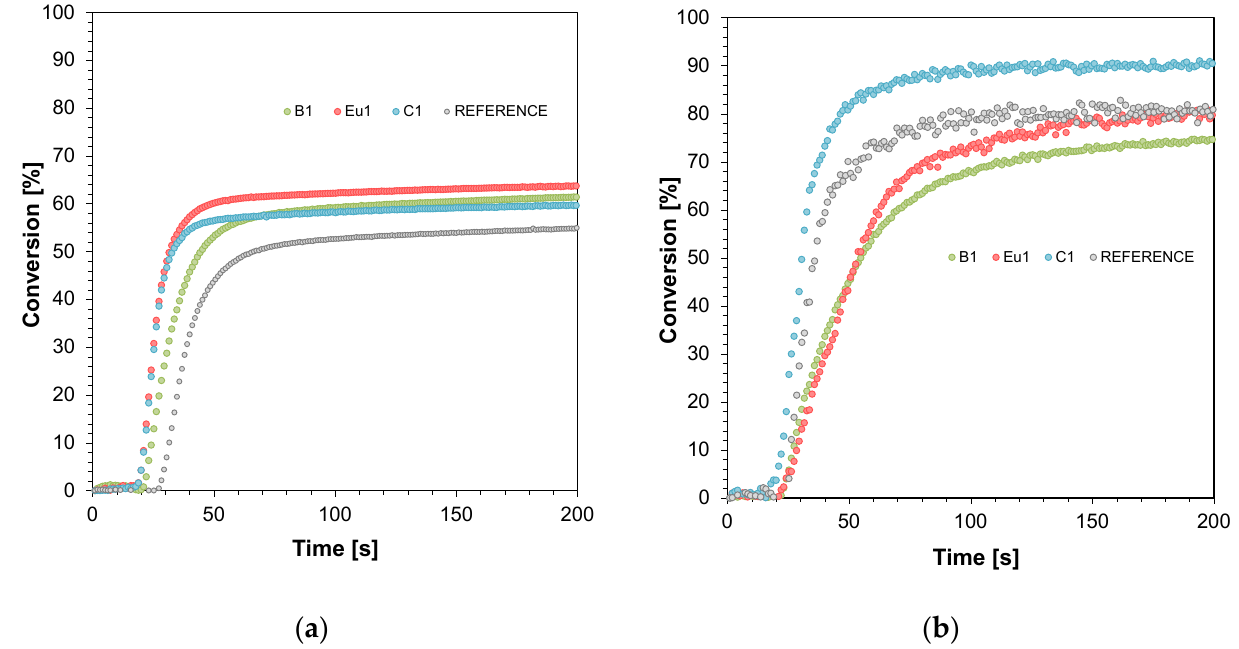
Figure 1. Polymerisation profiles based on TMPTA, IBOA, and BEDA monomers in a weight ratio of 1:2:7 (acrylate function conversion as a function of irradiation time) in the presence of different photoinitiating systems based on diphenyl(2,4,6-trimethylbenzoyl)phosphine oxide (TPO) and fluorescent dyes (0.1%) after irradiation with LED at 405 nm (0.4 mW/cm 2 ): ( a ) in thin layers (25 μ m) and ( b ) thick layers (0.5 mm). Irradiation starts at t = 10 s. Comparing the photopolymerisation results performed in thin layers shows significant differences in the achieved conversion rates (Figure 1a). In each case, the addition of the